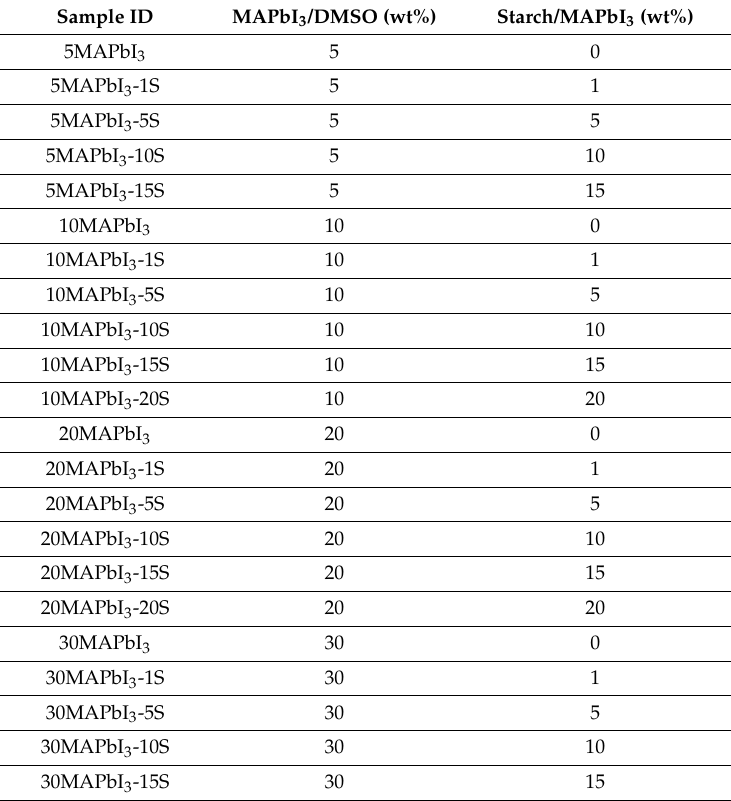
Table 1. Samples ID and